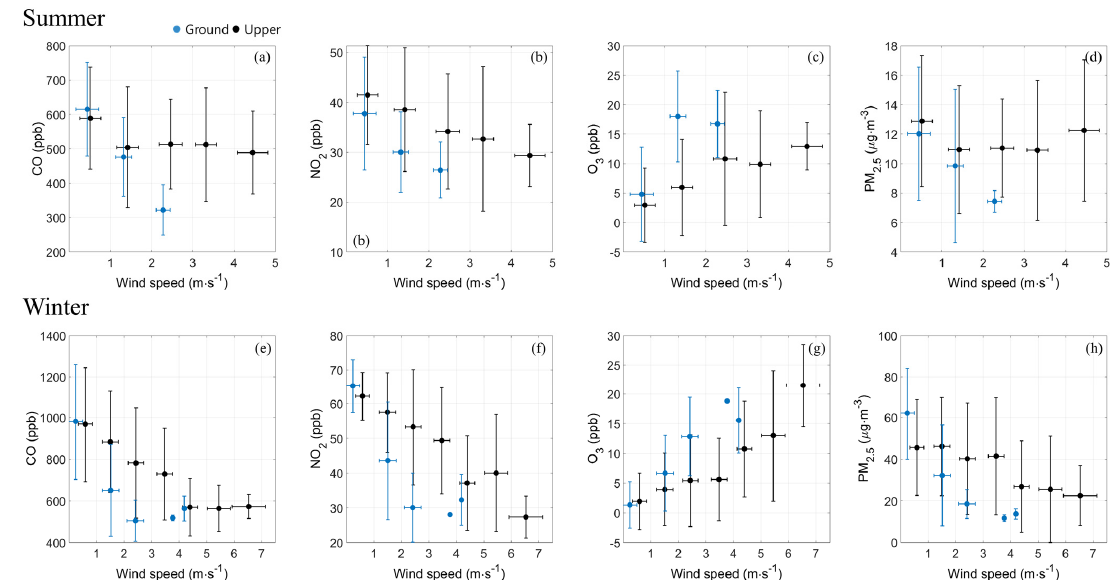
Figure 3. Air pollutant concentrations (at Site − 1 in summer and Site − 2 in winter) as a function of wind speed (blue circles: ground wind speed; black circles: prevailing wind speed). Error bars denote standard deviations. ( a – d ) CO, NO 2 , O 3 , and PM 2.5 in summer (at Site-1), ( e – h ) CO, NO 2 , O 3 , and PM 2.5 in winter (at Site-2).